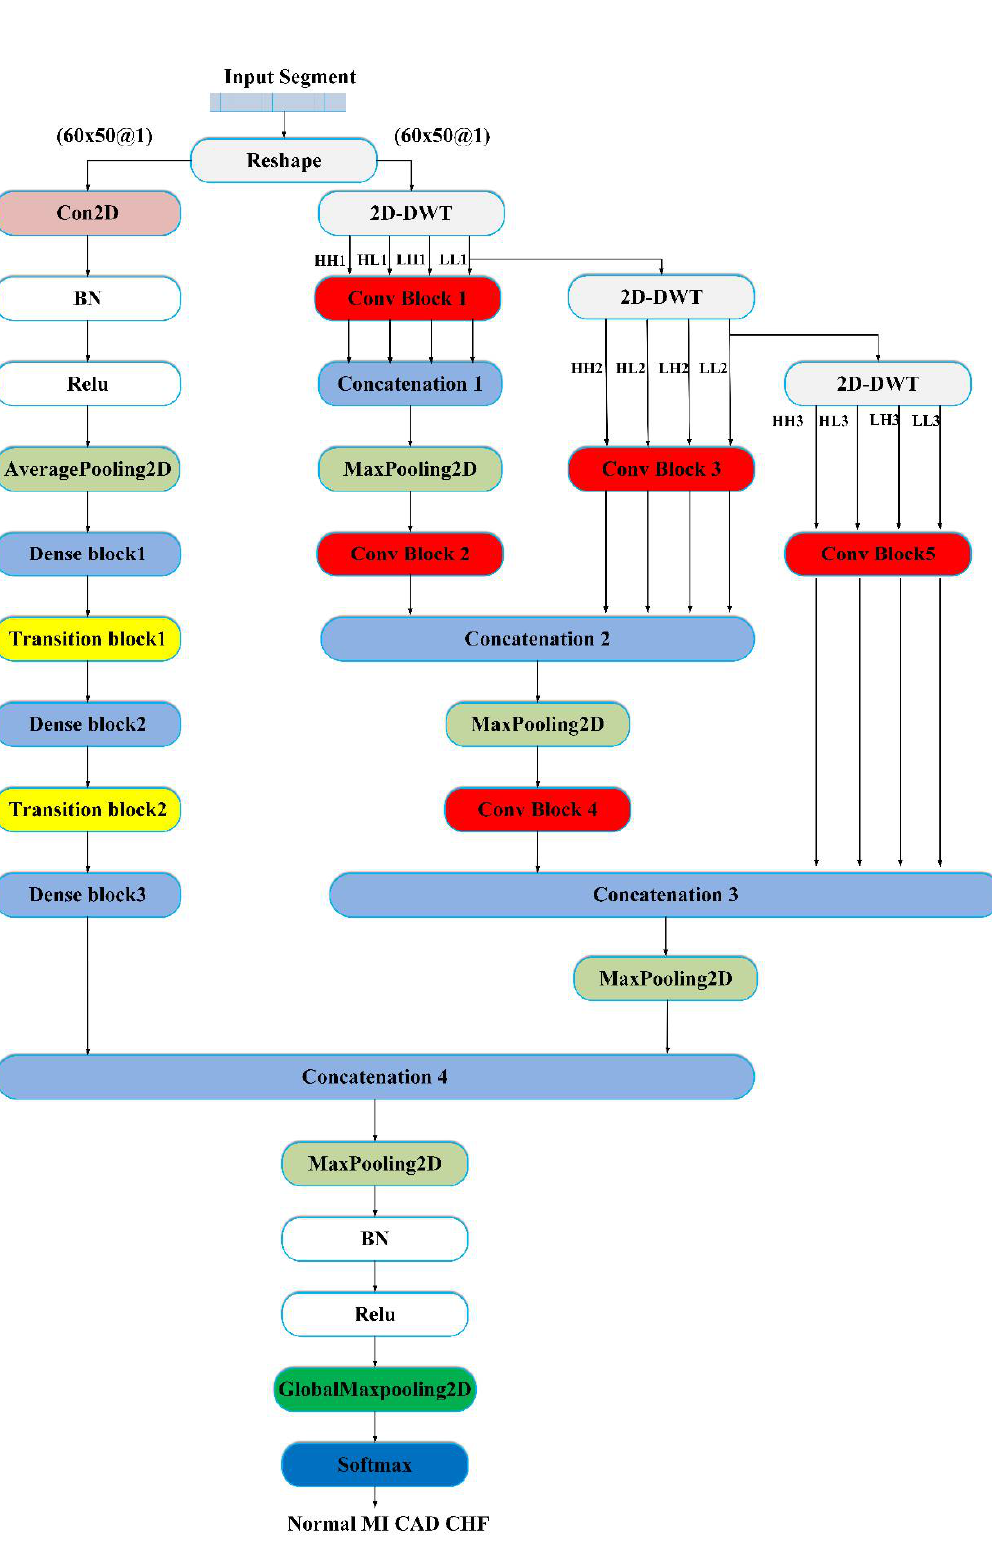
Figure 5. Flowchart of the proposed deep learning framework (MDD-Net) for cardiovascular disease. BN = Batch Normalization, Relu = Rectified Unit Activation.